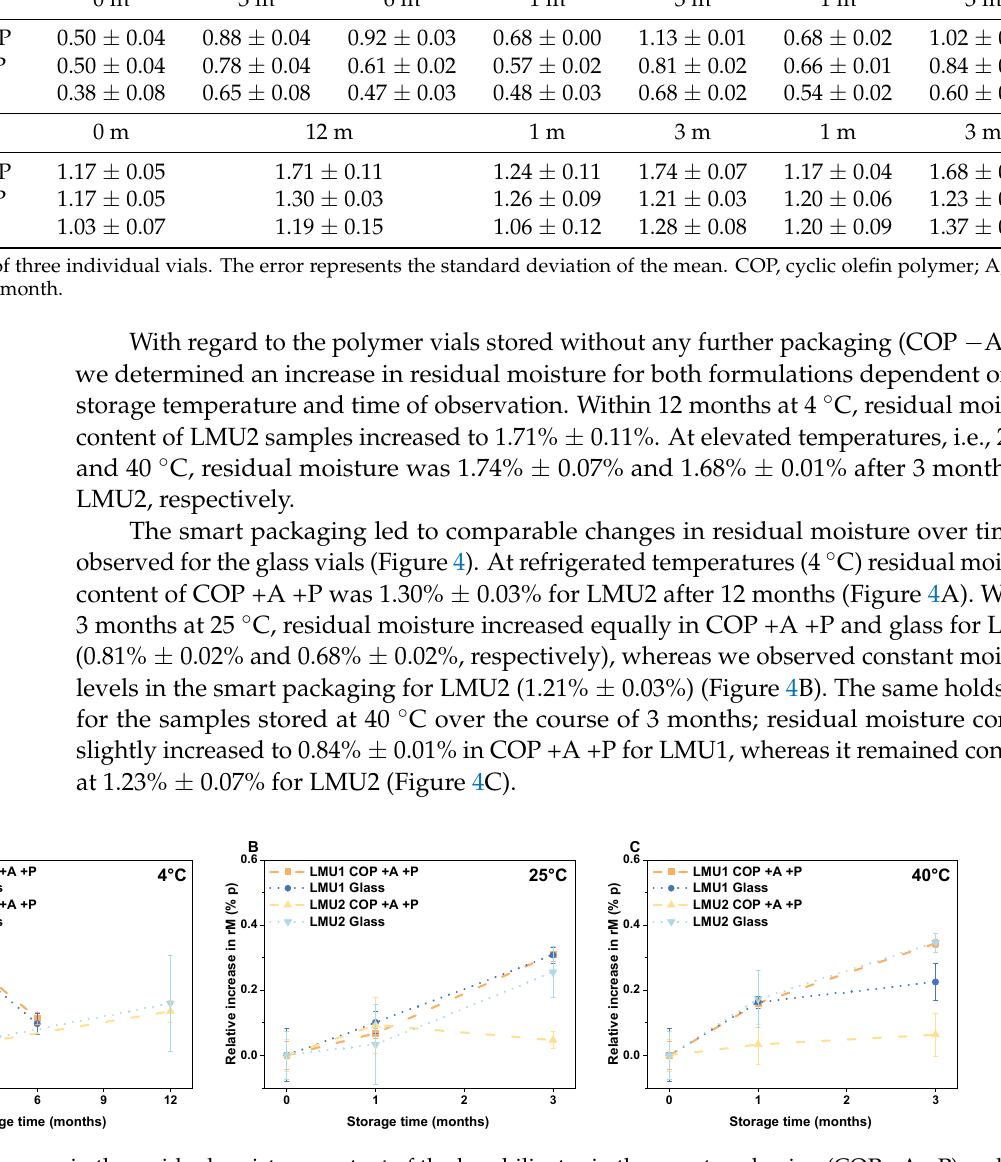
Figure 4. Relative changes in the residual moisture content of the lyophilizates in the smart packaging (COP +A +P) and glass stored at ( A ) 4 °C, ( B ) 25 °C and ( C ) 40 °C up to 6 months (LMU1) and 12 months (LMU2). Residual moisture content directly after lyophilization was set to 0% p for all configurations. The values are means ( n = 3) ± standard deviation. COP, cyclic olefin polymer; A, absorber; P, pouch, % p, percentage point.